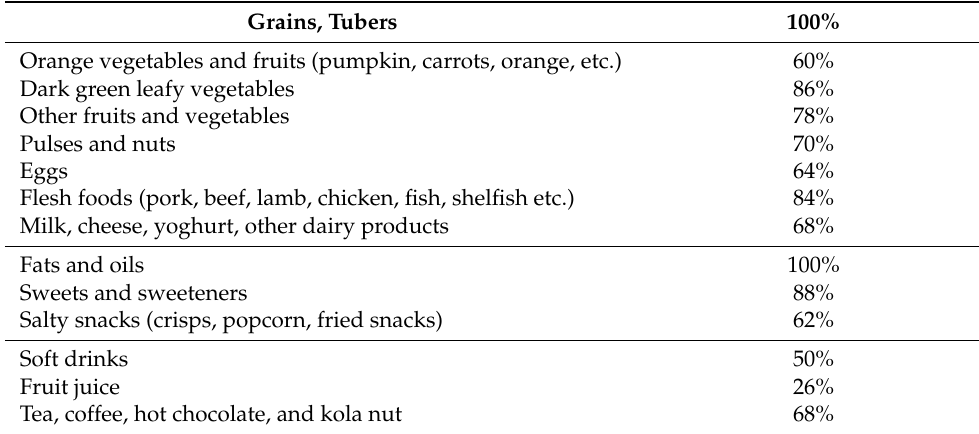
Table A3. Food groups consumed by Oyo children in the 2 days prior to the survey [13]. Grains, Tubers 100% Orange vegetables and fruits (pumpkin, carrots, orange, etc.) Dark green leafy vegetables